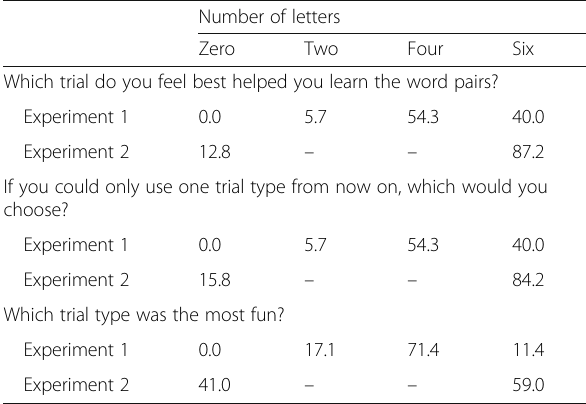
Table 1 Percentage of choices on the final questionnaire for each trial type in Experiments 1 and 2